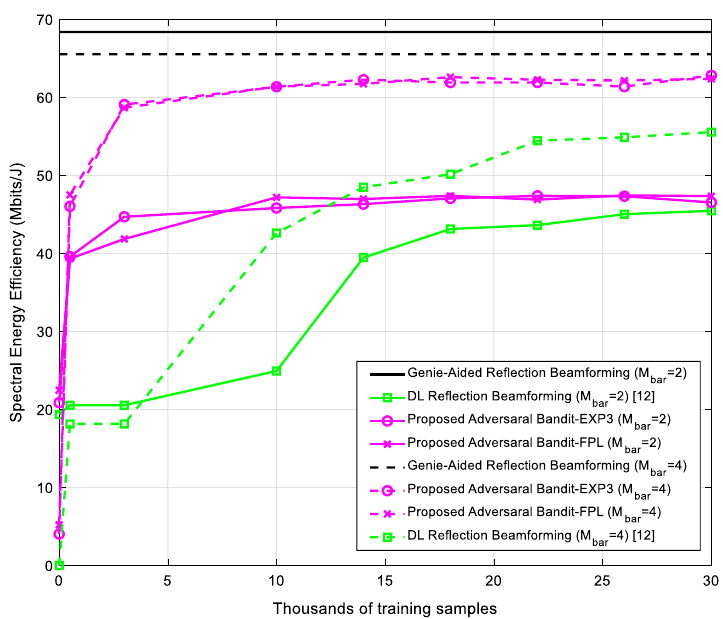
Fig. 6 The spectral energy efficiency versus the number of training samples and the number of active elements M for the proposed FPL-based